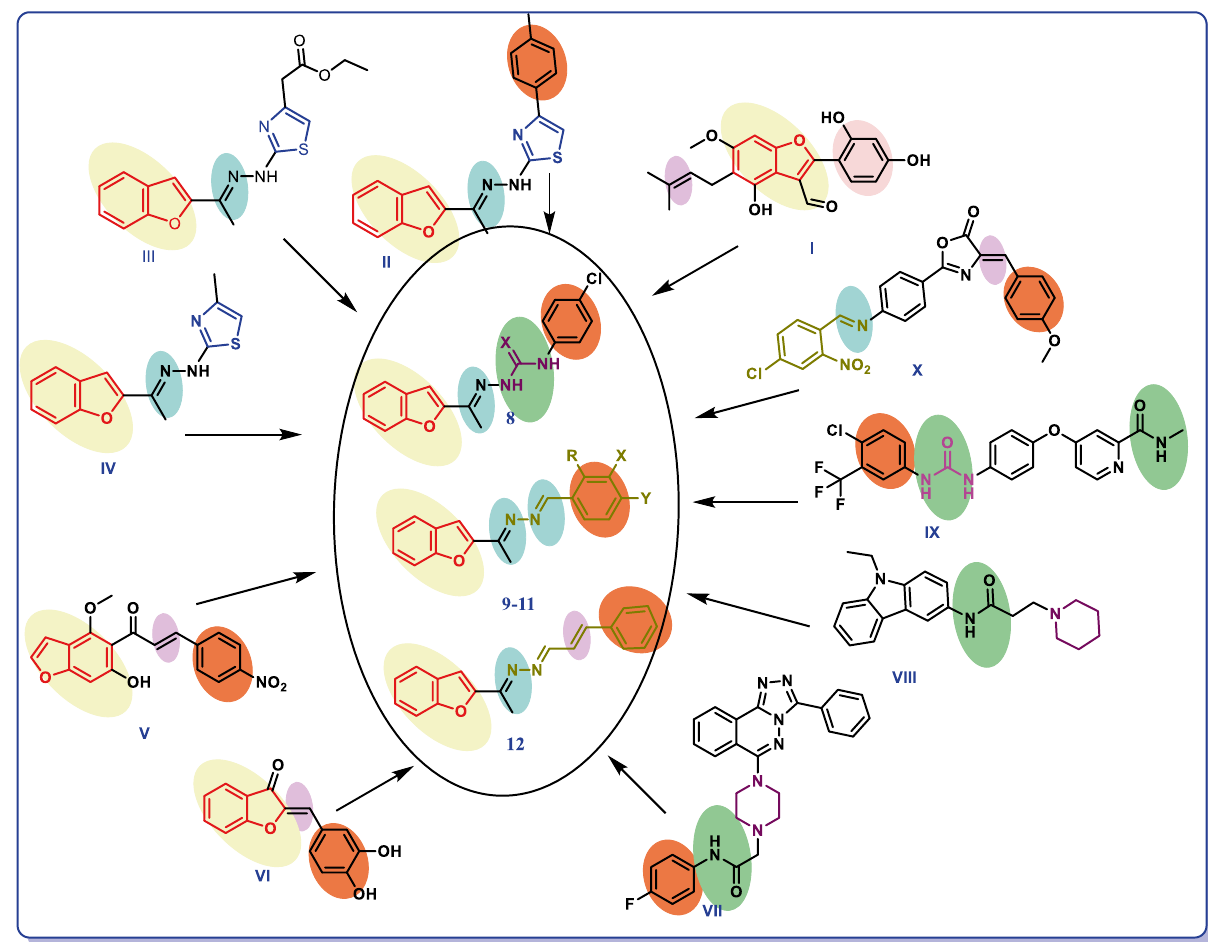
Figure 1. Structures of some reported benzofuran hybrids and PI3K and VEGFR-2 inhibitors, with color map molecular hybridization rational